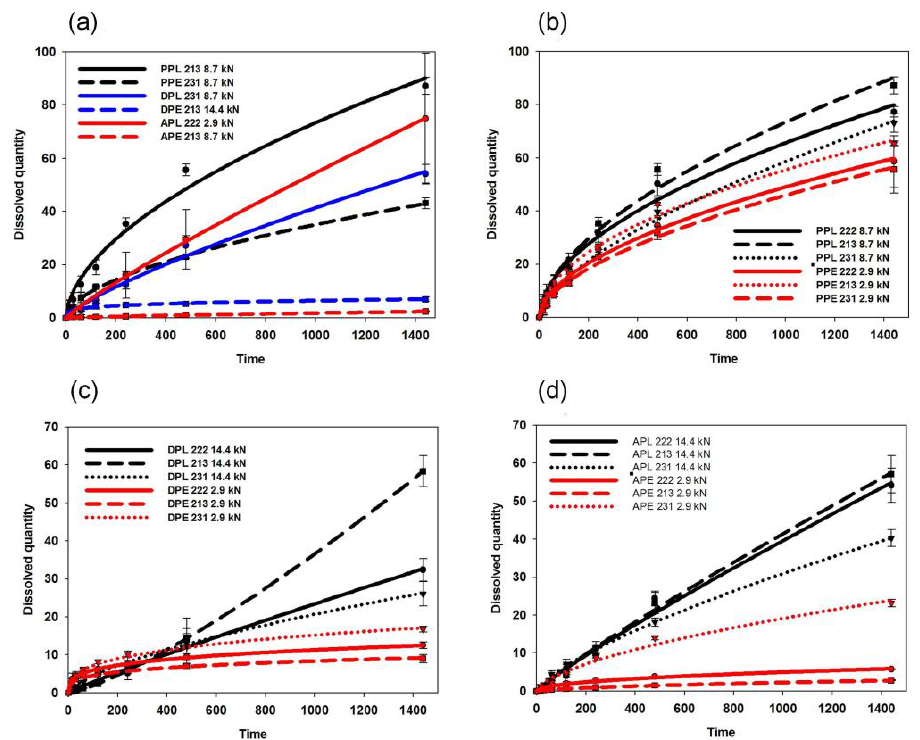
Figure 6. Drug release from various matrices: effect of the drug and polymer properties ( a ) and effect of the composition and compression force for PAR- ( b ), DIS- ( c ) and ACE- ( d ) containing ma- trices.